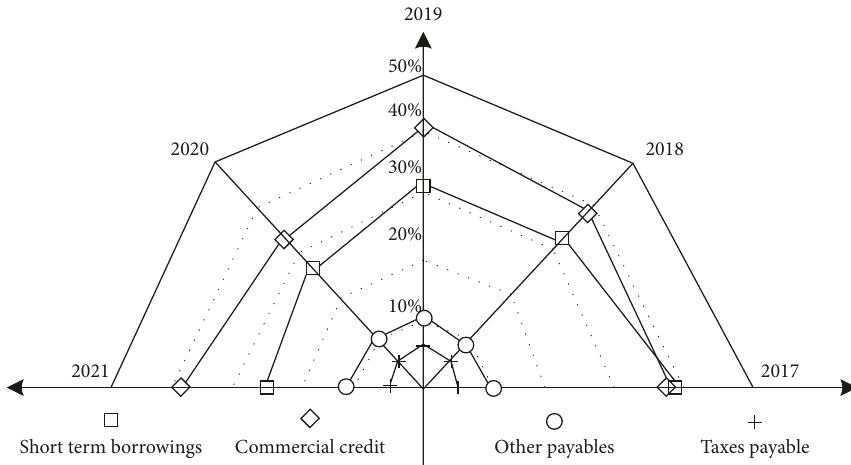
Figure 5: Structural proportion relationship of various indicators in a short-term debt